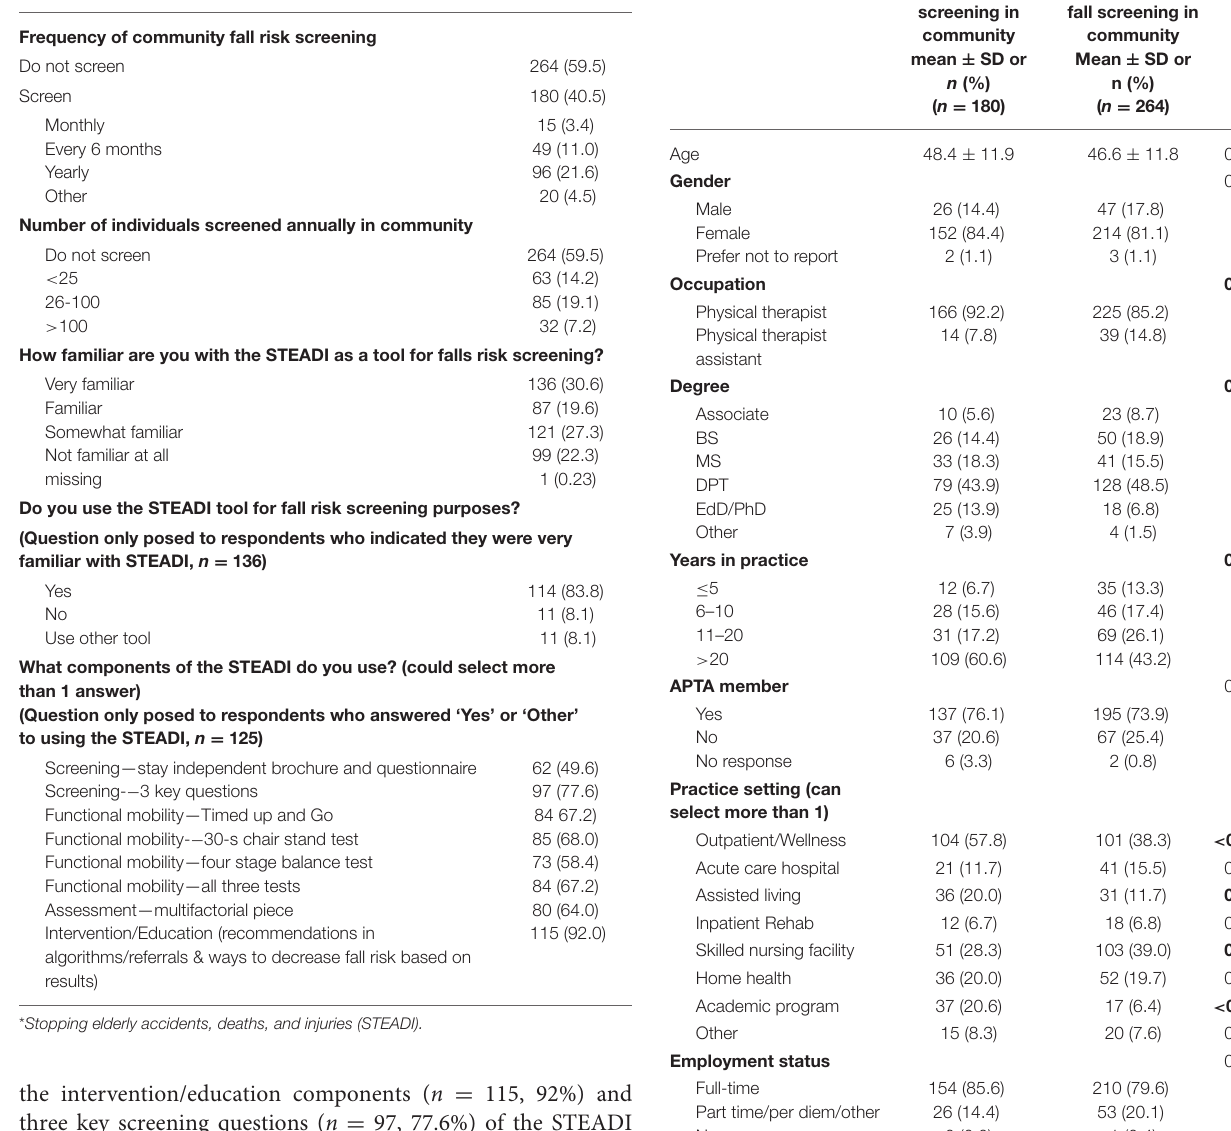
TABLE 3 | Demographics of physical therapists and physical therapist assistants by community fall risk screening status. Conduct Fall screening